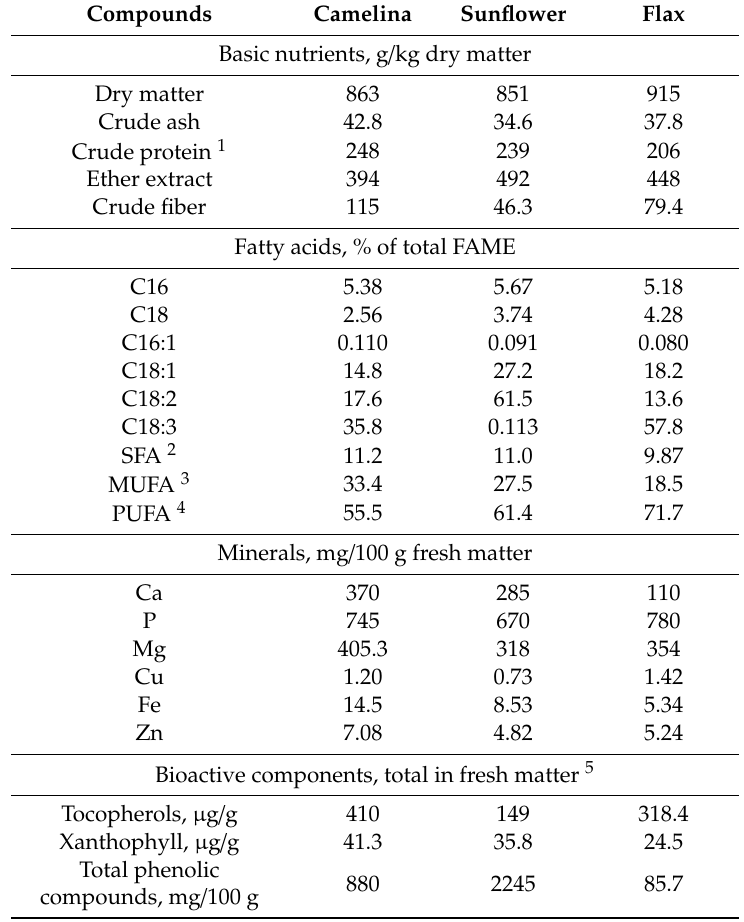
Table 1. Chemical composition of camelina, sunflower (dehulled), and flax seeds.